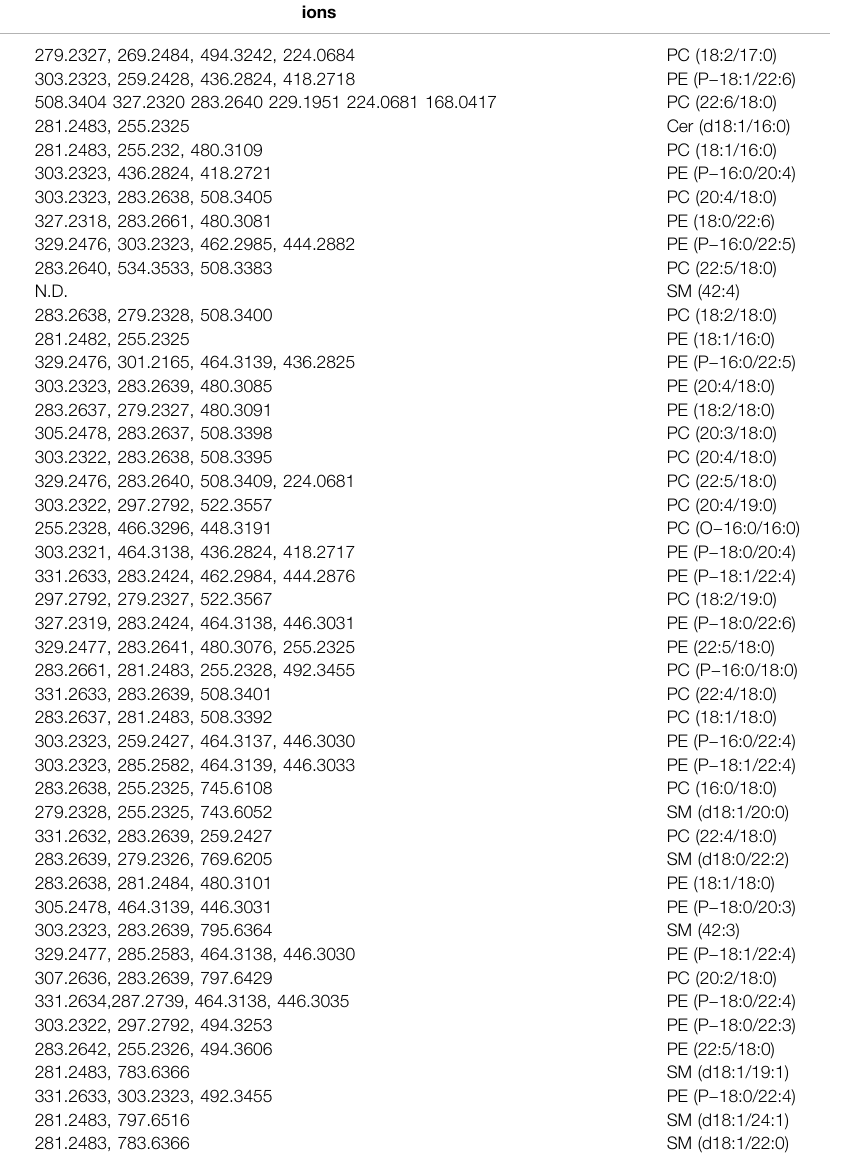
Molecular formula Characteristic Fragment